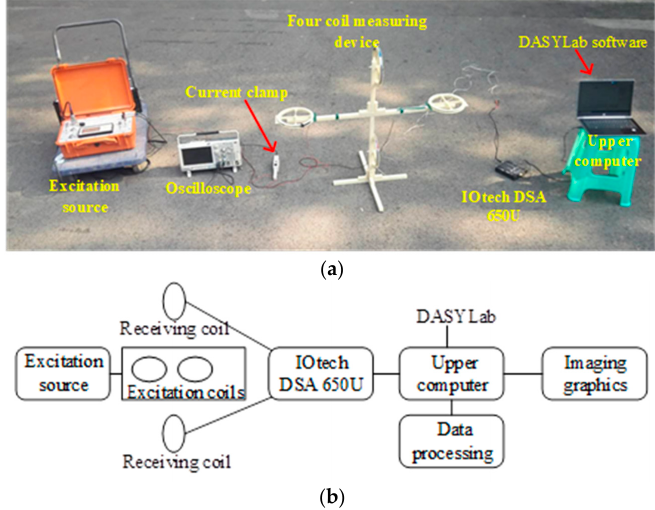
Figure 16. The measurement system: ( a ) Photograph of the equipment wiring for the experimental system; and ( b ) schematic diagram of the experimental process.